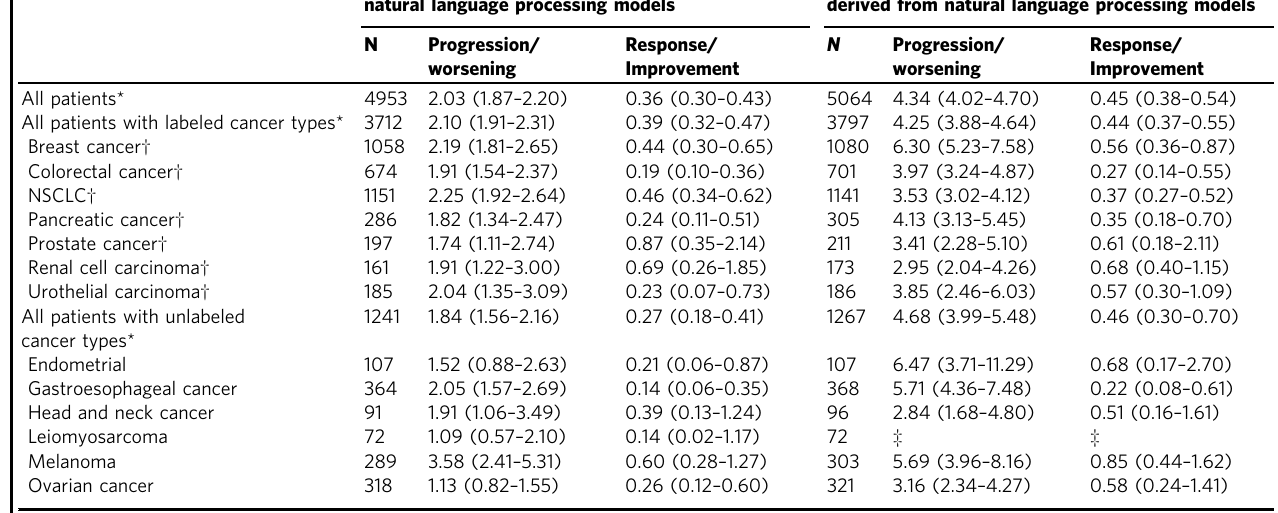
Hazard ratios derived from multivariable models including all PRISSMM imaging outcomes, which were treated as time-varying covariates. Hazard ratios therefore capture the differential mortality risks associated with time periods following either cancer progression/worsening or cancer response/improvement. Only time following genomic testing was treated as at risk for mortality, since genomic testing was a cohort eligibility criterion. Automated annotations were derived from NLP models using a cross-validation approach, such that inference for each patient was performed using models that excluded that patient from training. *Analysis also adjusted for cancer type. † Labeled cancer type (labeled data for this individual cancer type were used to train NLP models). ‡ Insuf fi cient data for stable regression